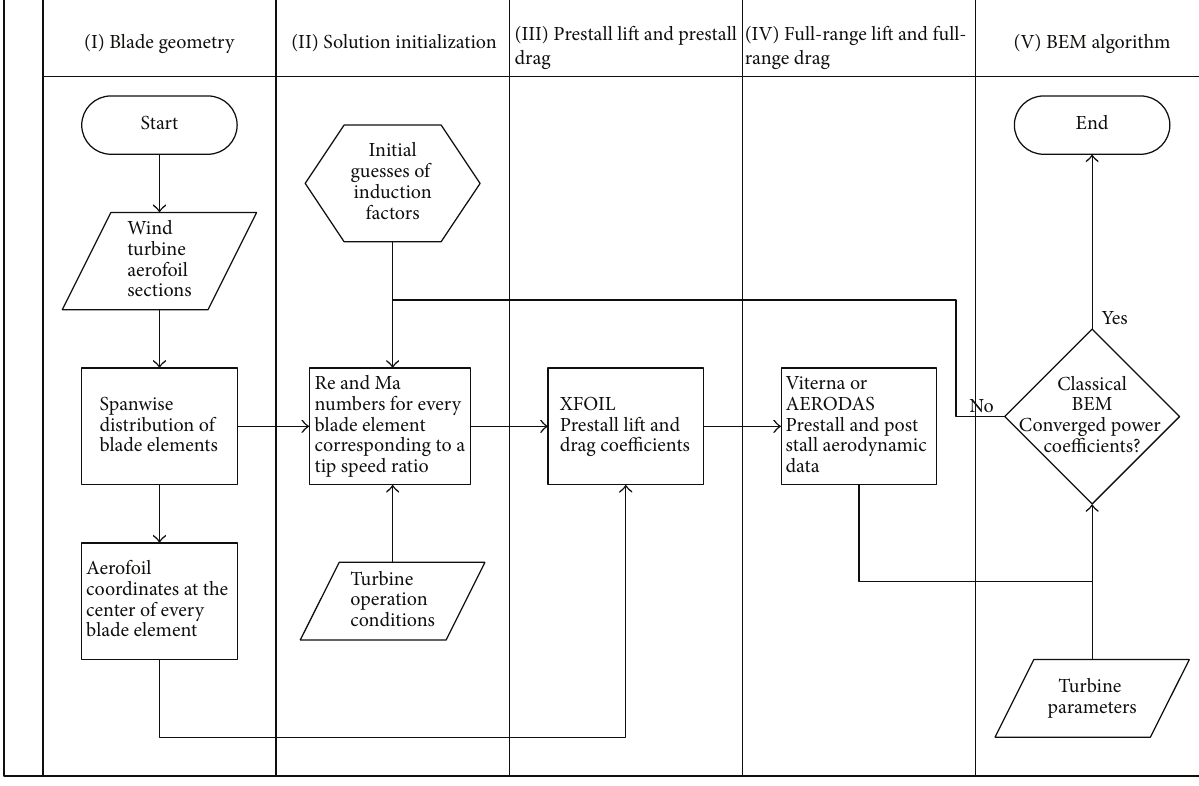
Figure 3: Flowchart of the extended BEM procedure for calculating wind turbine